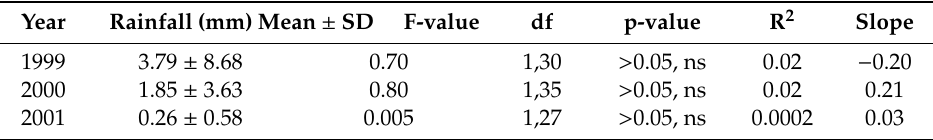
Table 1. Results from regression analyses of number of nests oviposited vs. daily rainfall (mm) during three consecutive years. Variables were Log n